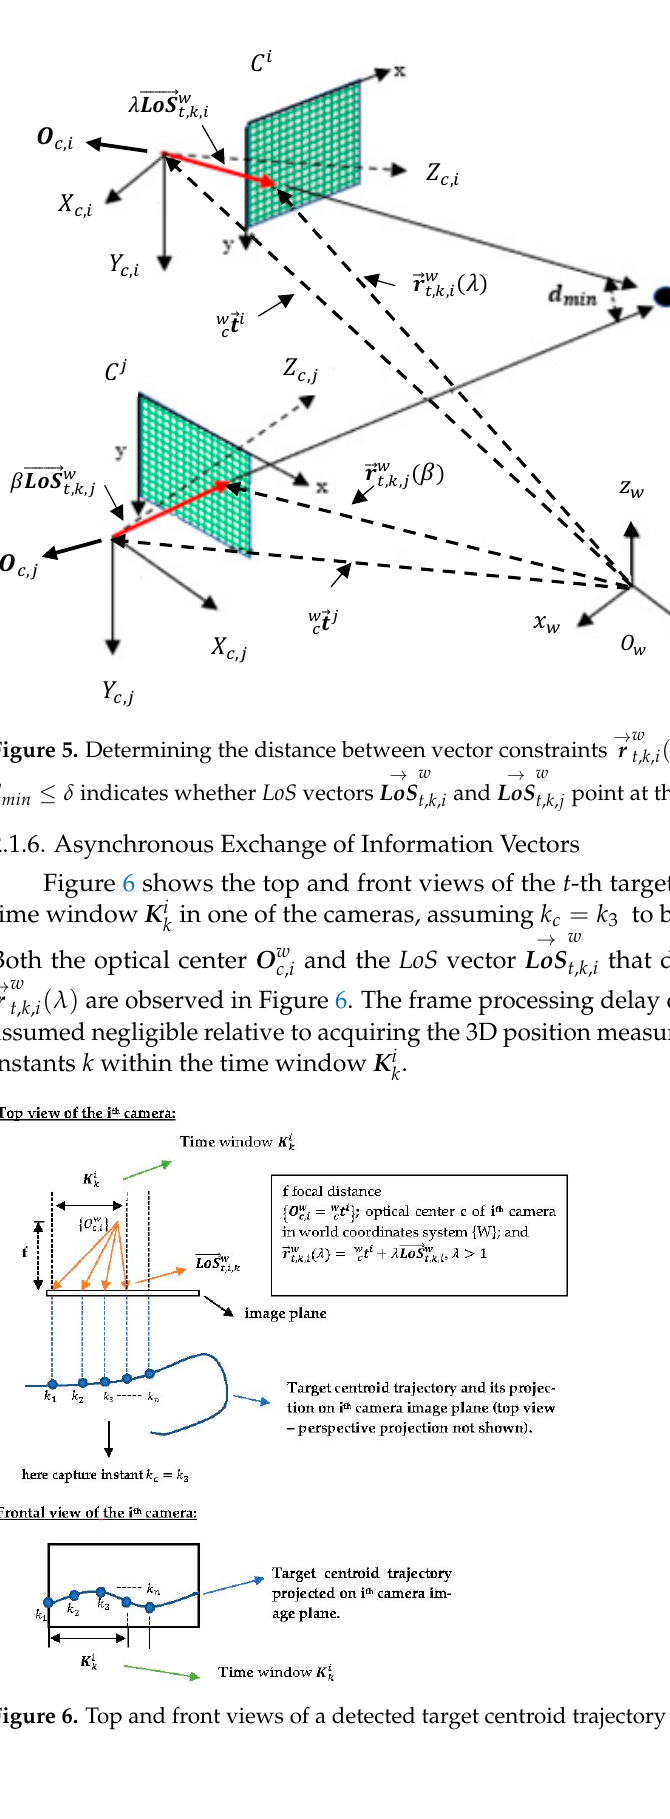
Figure 7. LoS vectors from Camera 1 to Target 1 𝑳𝒐𝑺(cid:4652)(cid:4652)(cid:4652)(cid:4652)(cid:4652)(cid:4652)(cid:4652)⃗ (cid:2869),(cid:3038),(cid:2869)(cid:3050) ,𝑘 = 1,...,4 in the image plane in {W} coordinates during the time window 𝑲 (cid:3038)(cid:2869) and the interpolated trajectory. The data will be stored in the information vectors 𝒊 (cid:2869),(cid:3038),(cid:2869)(cid:3050) = {𝑘;𝑶 (cid:3030),(cid:2869)(cid:3050) ;𝑳𝒐𝑺(cid:4652)(cid:4652)(cid:4652)(cid:4652)(cid:4652)(cid:4652)(cid:4652)⃗ (cid:2869),(cid:3038),(cid:2869)(cid:3050) } for each k -th instant within the time window 𝑲 (cid:3038)(cid:2869) . Following an idea reported in [34], the information vectors 𝒊 (cid:3047),(cid:3038),(cid:3036)(cid:3050) are stored for each k -th instant within the time window 𝑲 (cid:3038)(cid:3036) , as can be observed in Buffer 1 of the i -th camera in Figure 8. They are subsequently replaced by information vectors of the next time